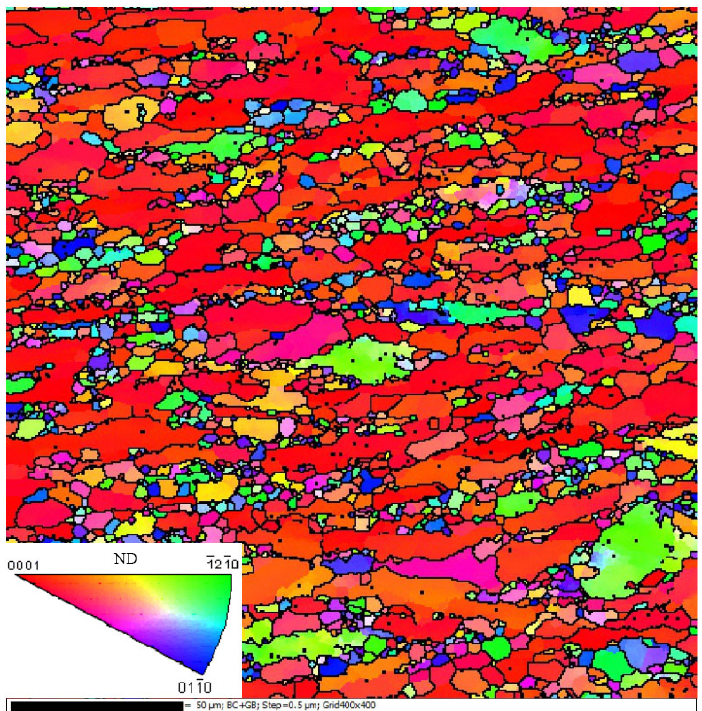
Figure 1. An electron backscatter diffraction (EBSD) normal direction (ND) inverse pole figure (IPF) map of the initial microstructure of the extruded ZK60.